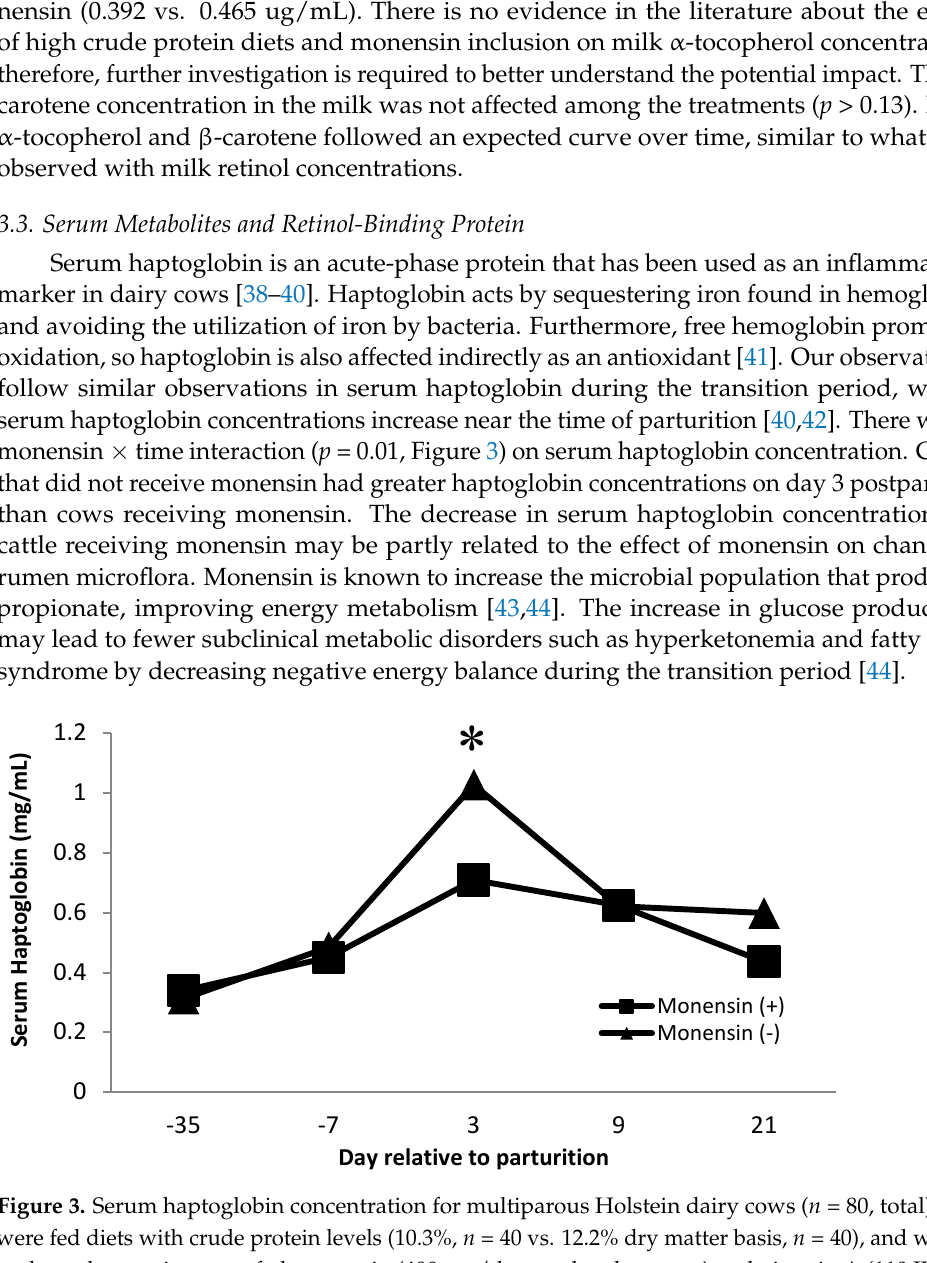
Table 5. Serum metabolites for multiparous Holstein dairy cows ( n = 80, total) that were fed diets with crude protein levels (10.3%, n = 40 vs. 12.2% dry matter basis, n = 40), and within each crude protein group fed monensin (400 mg/day per head or none) and vitamin A (110 IU/kg body weight or none) during prepartum period (from day − 35 to the day of calving). All cows received a common lactation ration postpartum.